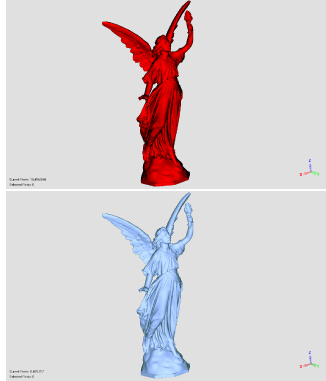
Figure 9: Lucy - Top: Laser, Bottom: Photogrammetry